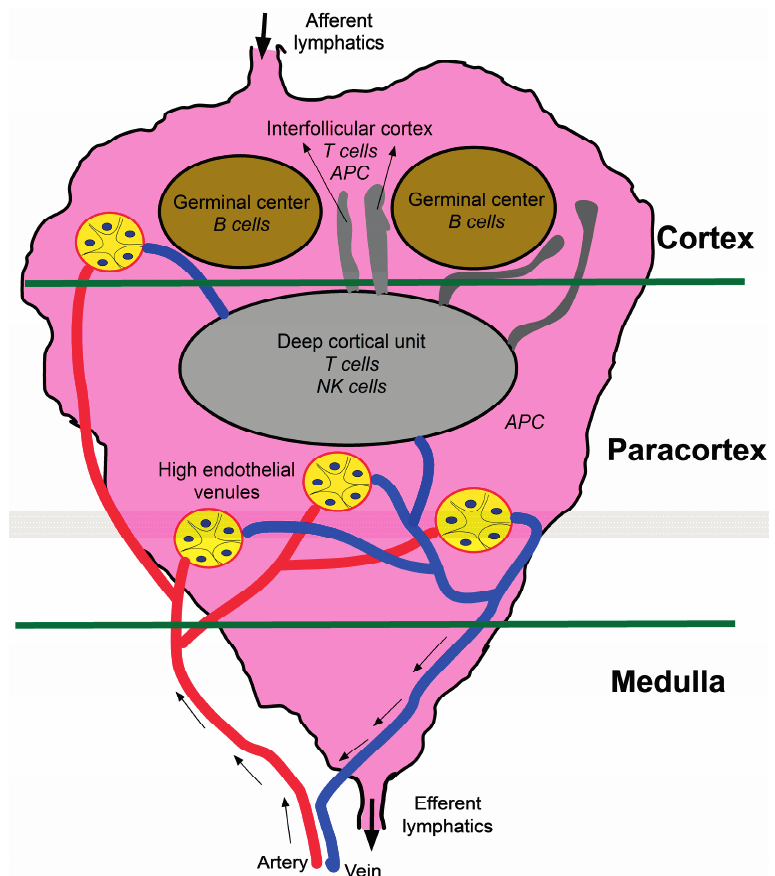
Figure 2. Schematic of a lymphoid lobule: The structural and functional unit of a LN is a lymphoid lobule. The number of lymphoid lobules per LN can vary depending on the size of the LN. The lymph enters the LN through the afferent lymphatics, is filtered through the LN and exits through the efferent lymphatics. The immune cells reach the LN through the high endothelial venules and are compartmentalized within the lymphoid lobule. The lymphoid lobule can be divided into three regions: cortex, paracortex and medulla. The cortex has germinal centers with B cells and an interfollicular cortex containing T cells and antigen presenting cells (APC). The paracortex is mostly filled with APC and has the deep cortical unit containing T-cells and NK cells. The medulla mostly consists of veins and lymphatic capillaries that drain the